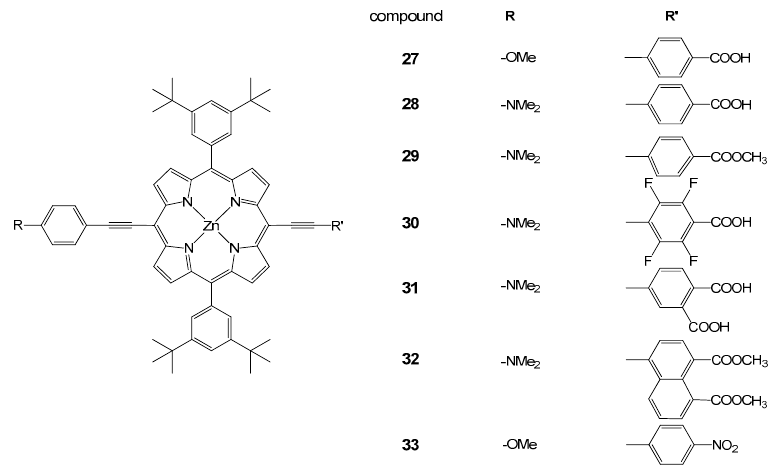
Figure 5. meso 5,15-Diarylzinc(II) porphyrins investigated. Adapted from Inorg. Chem. 2017 , 56 , 6438–6450.